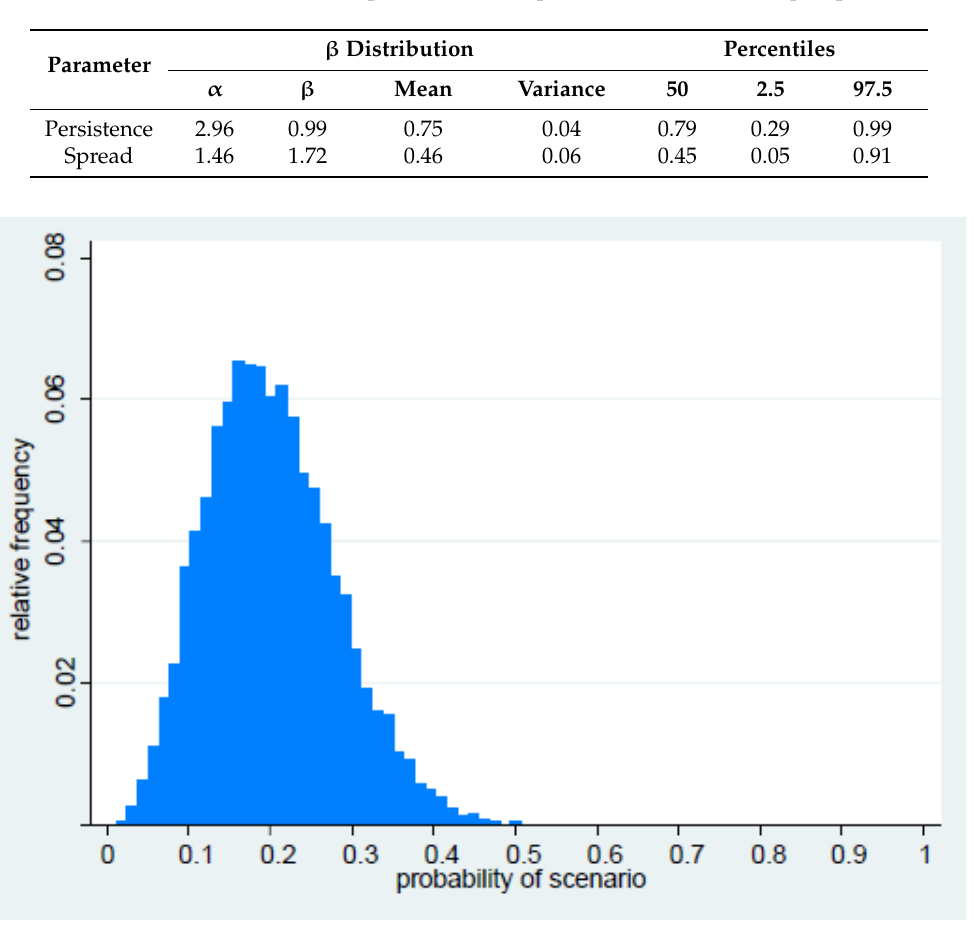
Figure 2. Posterior distribution of the probability of the scenario occurring within five years.